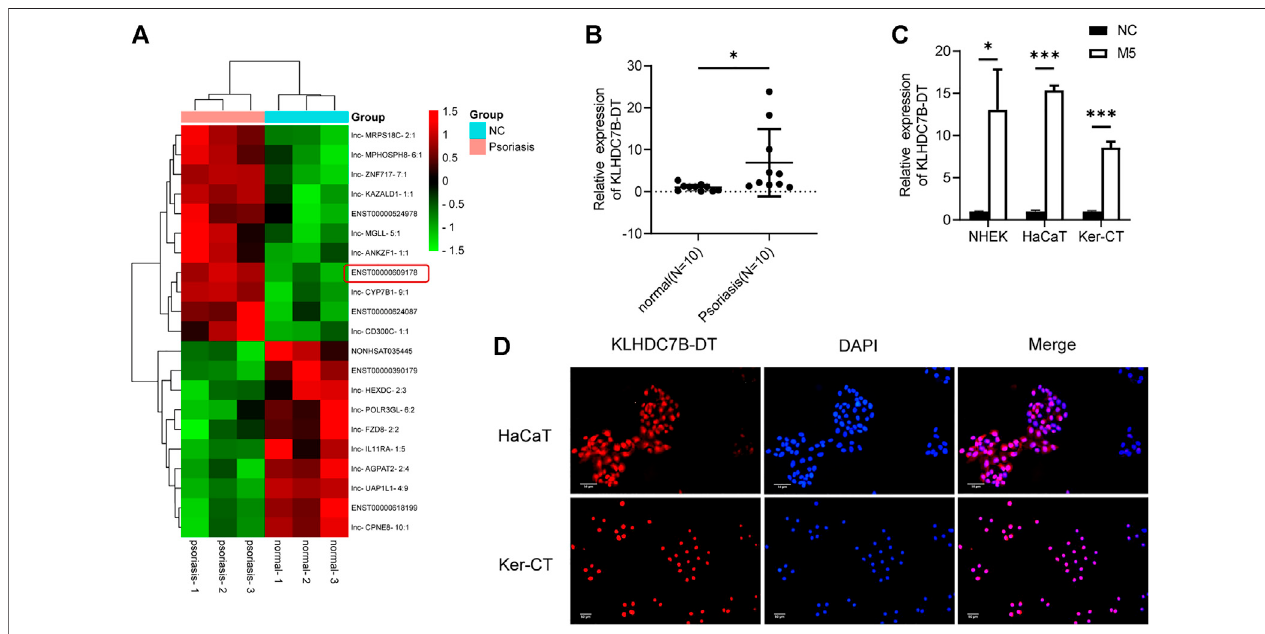
FIGURE1| KLHDC7B-DTisupregulated inpsoriatictissuesand M5-induced keratinocytes. (A) Differentially expressed lncRNAsdetected in psoriatic and normal skin tissues using a lncRNA microarray ( n = 3, Accession: GSE181318). (B) The expression level of KLDHC7B-DT in psoriatic tissues and normal controls ( n = 10). (C) The expression level of KLDHC7B-DT in M5-induced NHEKs, HaCaT cells, and Ker-CT cells. (D) Fluorescence in situ hybridization showed the expression and localization of KLDHC7B-DT in HaCaT and Ker-CT cells. A Cy3-labelled probe (red) was used to show KLDHC7B-DT. DAPI (blue) was performed to show the nuclei of cells. Data are shown as the means ± SD, * p < 0.05, *** p < 0.001. All experiments were repeated at least three times. NHEK: normal human epidermal